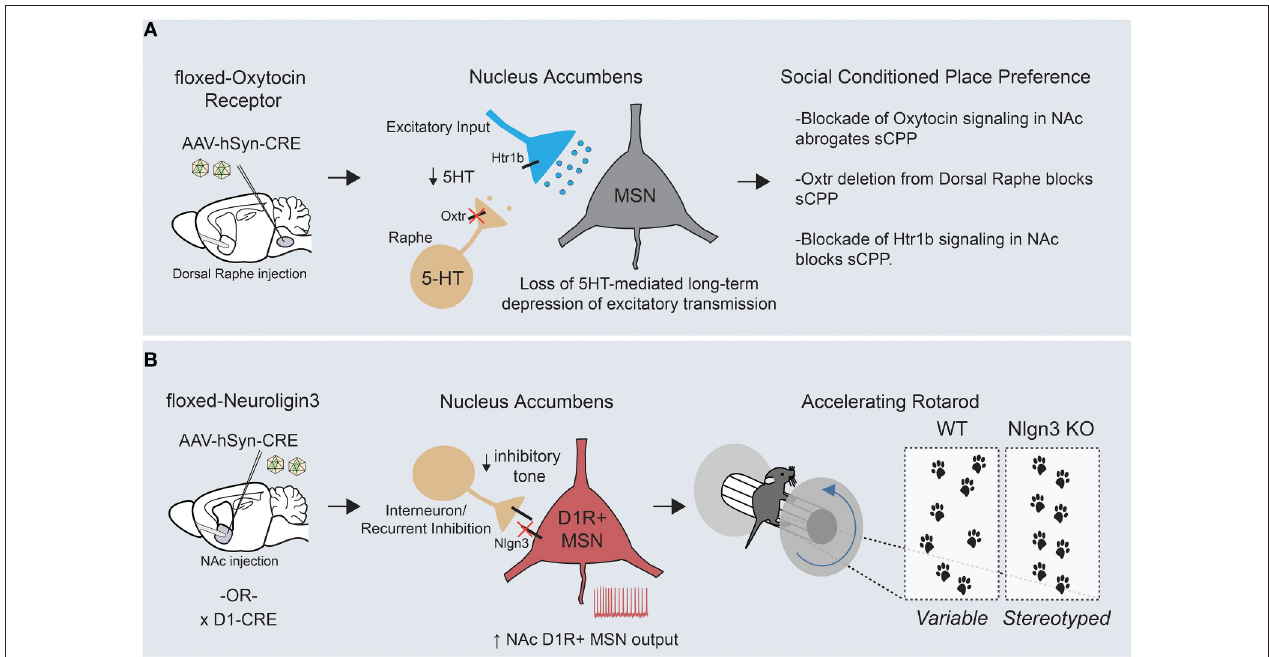
FIGURE 4 | Circuit-specific analysis of ASD-related behaviors points toward an underlying striatal deficit. (A) Targeted removal of oxytocin receptor within the dorsal raphe demonstrates a key role for this molecule in formation of social conditioned place preference, a measure of social reward. Oxytocin receptor functions on dorsal raphe terminals within the nucleus accumbens to regulate the release of serotonin, which can hetero-synaptically modulate excitatory transmission onto MSNs through presynaptic Htr1b receptors. (B) Removal of Neuroligin-3, a synaptic adhesion molecule associated with ASD, from D1R+ MSNs of the nucleus accumbens is sufficient to drive the enhanced formation of repetitive motor routines, as assayed by learning on the accelerating rotarod (KOs display an increased and earlier stereotyped pattern of foot placements compared with WTs). In addition, Neuroligin-3 KO mice have a cell type- specific deficit in inhibitory transmission onto accumbens D1R+ MSNs, which presumably leads to an increase in output from this